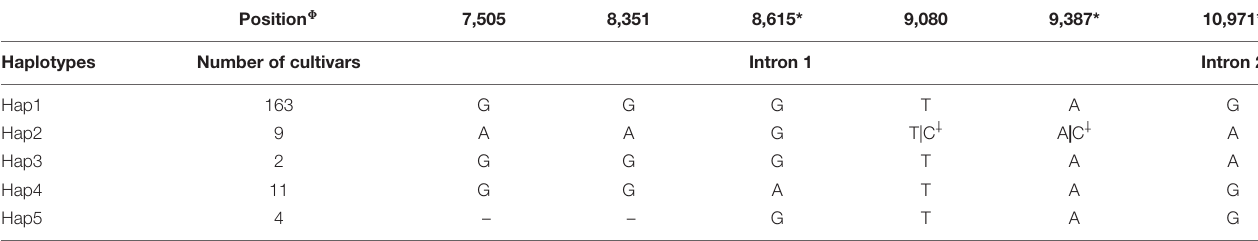
TABLE 5 | SNPs and haplotypes detected in VRN-B1 genes of 188 cultivars 1 .